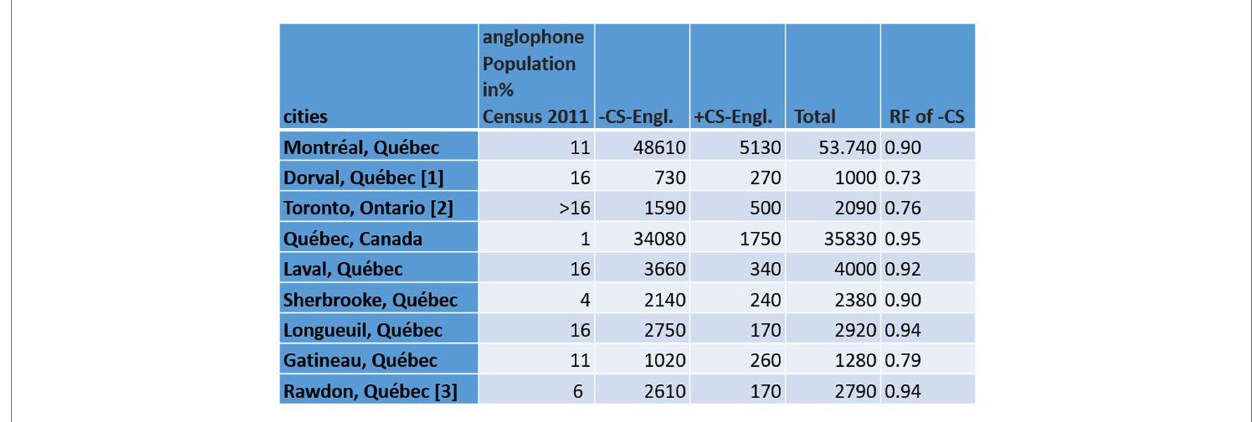
FIGURE 2 Number of Tweets with and without CS in cities extracted by “city name” from Twitter that have a higher number than 150 Tweets for +CS. Right most column: Relative Frequency calculation of –CS: – CS/Total. [1] Dorval has not been studied as a separated city from the island of Montreal according to Canadian census 2011. This is why I use the same number of population as the island of Montreal. [2] https://www.ontario.ca/document/2016-census- highlights/fact-sheet-6-mother-tongue-and-language. [3] https://www12.statcan.gc.ca/census-recensement/2021/as-sa/fogs-spg/page.cfm?dguid= 2021A00052462037&lang=F&topic=1.